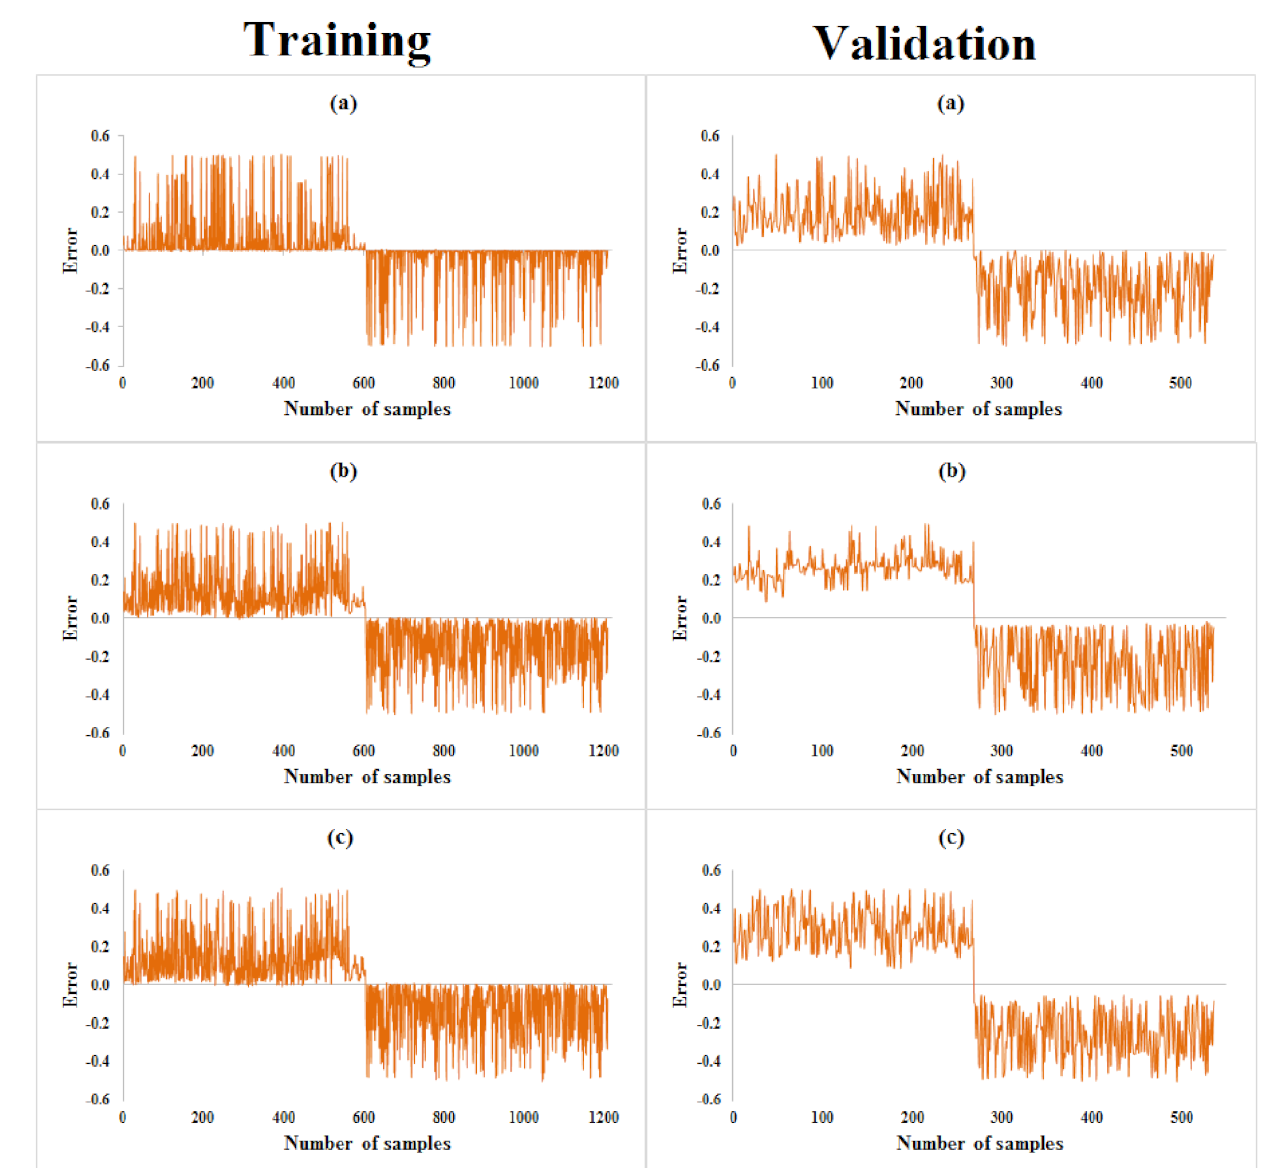
Figure 5. Results of prediction error by: ( a ) AdaBoost, ( b ) Bagging, and ( c )